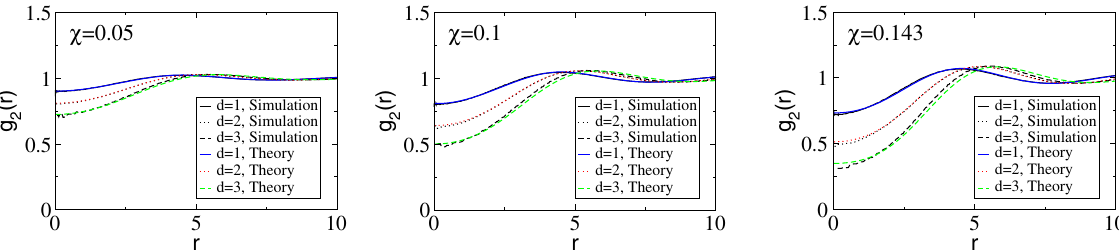
FIG. 7. Comparison of theoretical and simulation results for the pair correlation function g 2 ð r Þ for χ ¼ 0 . 05 , 0.1, and 0.143 across the first three space dimensions. Here, K ¼ 1